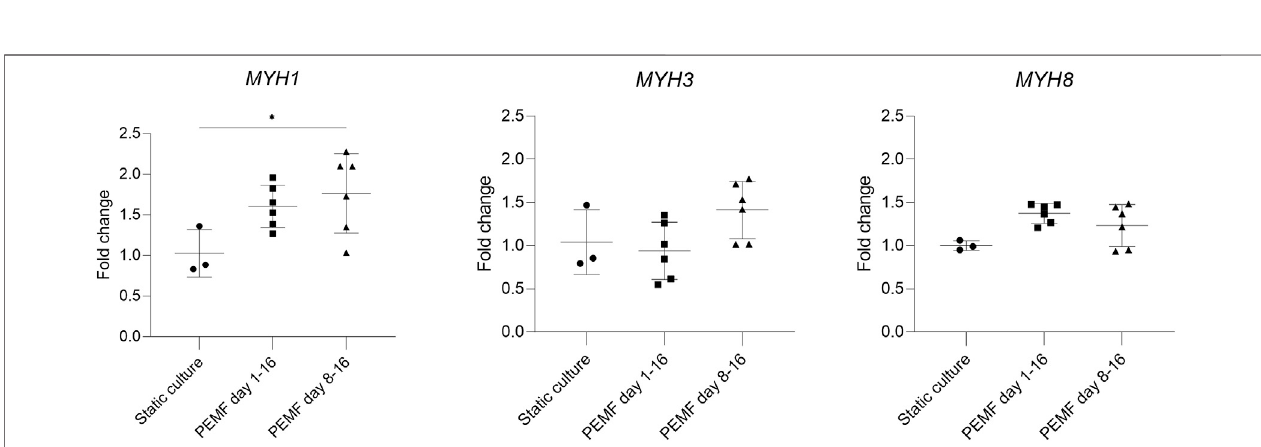
FIGURE5| RT-qPCRanalysisoftheconstructs( n =3control, n =6stimulatedconditions).PEMFgroupswerecomparedtostaticculturebyone-wayANOVA.The difference in expression of MYH1 indicates a tendency for mature construct formation.